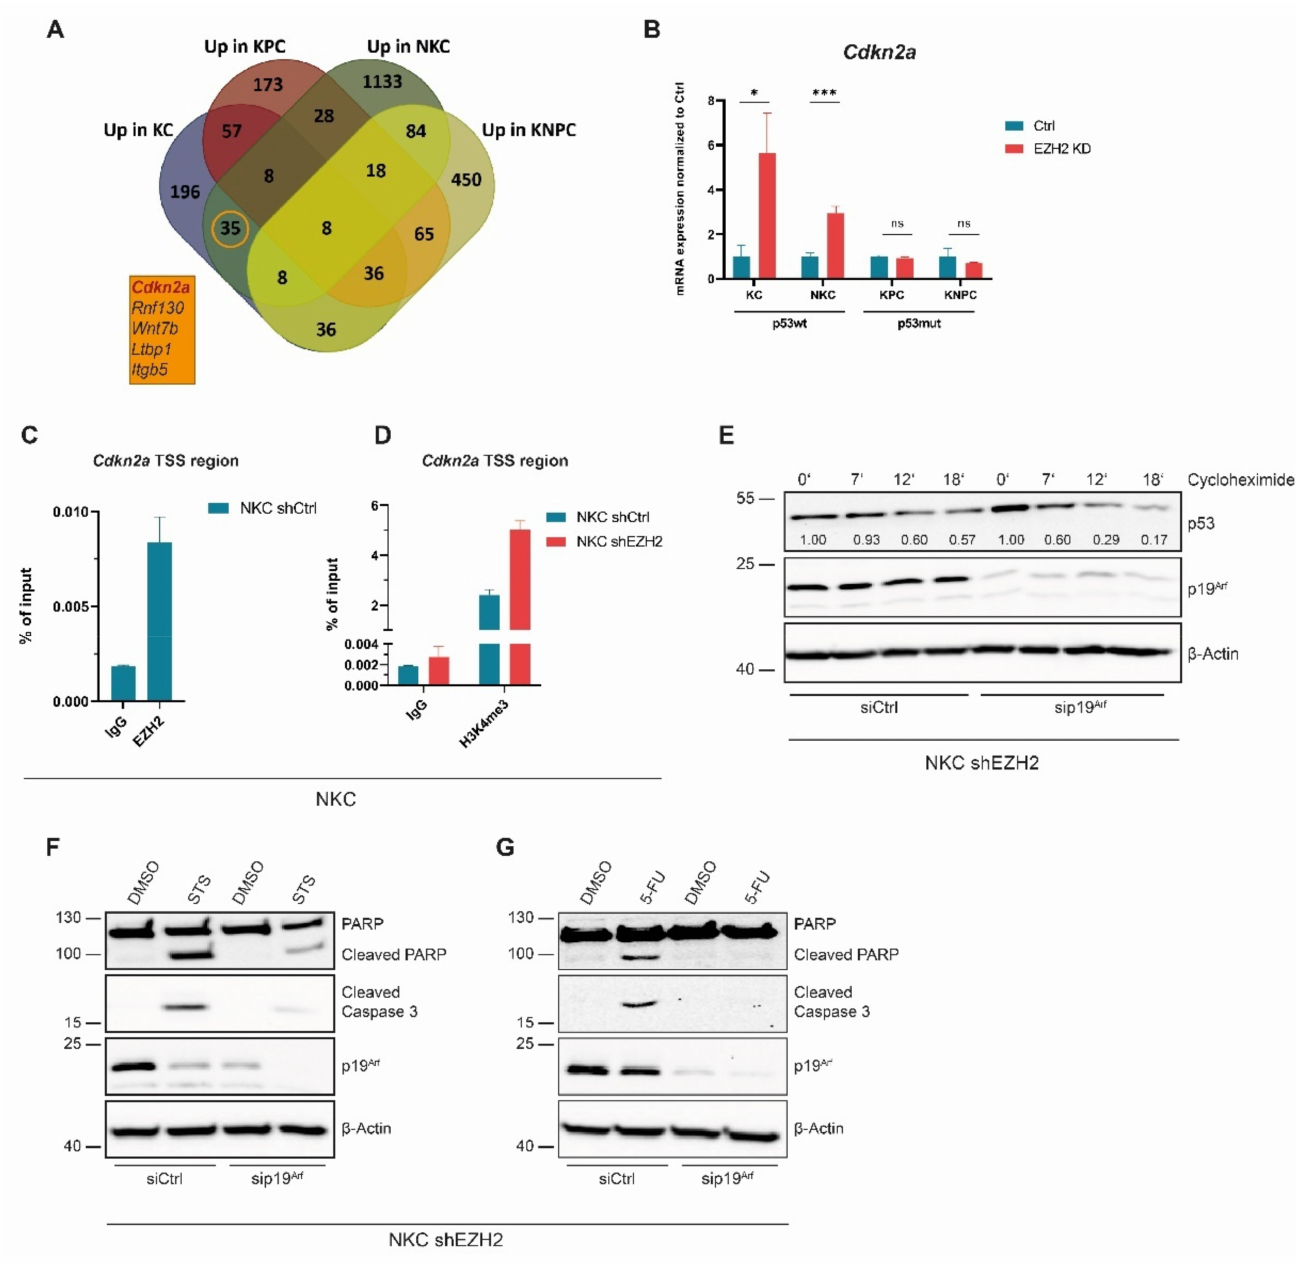
Figure 5. EZH2 regulates p53 via Cdkn2a . ( A ) Venn diagram showing the overlay of significantly upregulated (FPKM > 0.01, log2FC > 0.5, q < 0.05) genes in the indicated PDAC cells upon knockdown of EZH2. Box depicts an excerpt of five exemplary genes of the 35 genes that are only upregulated in p53wt but not in p53mut PDAC cells. ( B ) Cdkn2a expression in the indicated PDAC cells upon EZH2 depletion analysed by qRT-PCR ( n = 3). Values represent mean ± SD. Significance was determined by Student’s t -test; *, p ≤ 0.05; ***, p ≤ 0.001; ns, non-significant. ( C , D ) ChIP and subsequent qRT-PCR in NKC cells displaying occupancy of EZH2 at the Cdkn2a TSS region ( C ) and increased